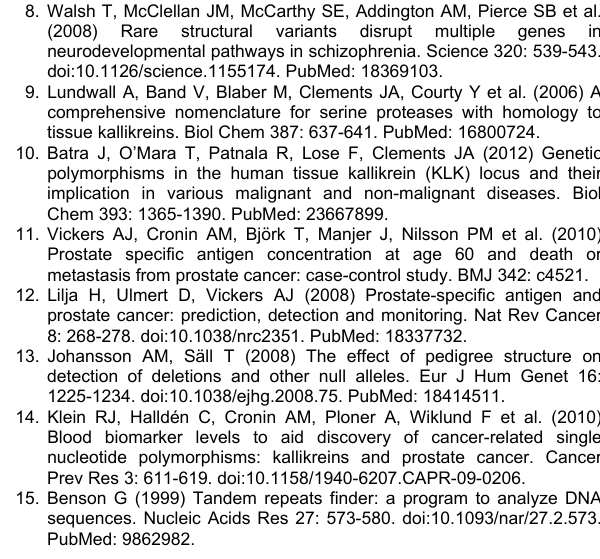
Table S3. Copy number assays in the kallikrein gene locus analyzed in this study. The assay information is from the Applied